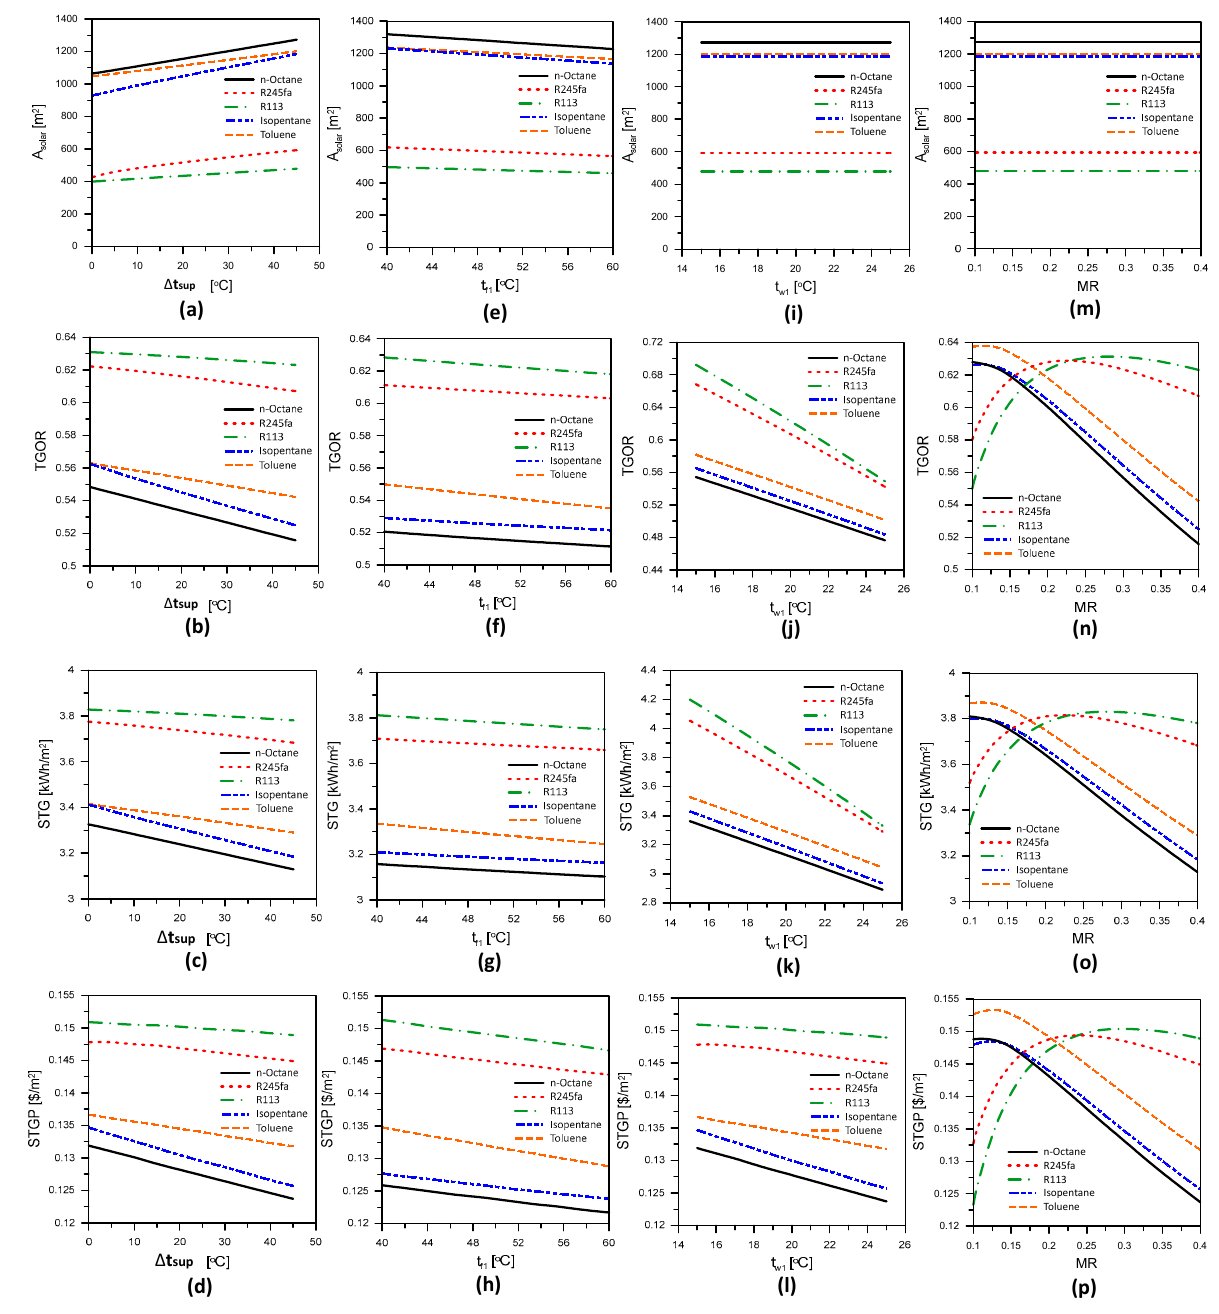
Figure 5. Variations of the systems’ performance indicators with various studied parameters: ( a – d ) Δ t sup ; ( e – h ) t f1 ; ( i – l ) t w1 ; ( m – p ) MR.